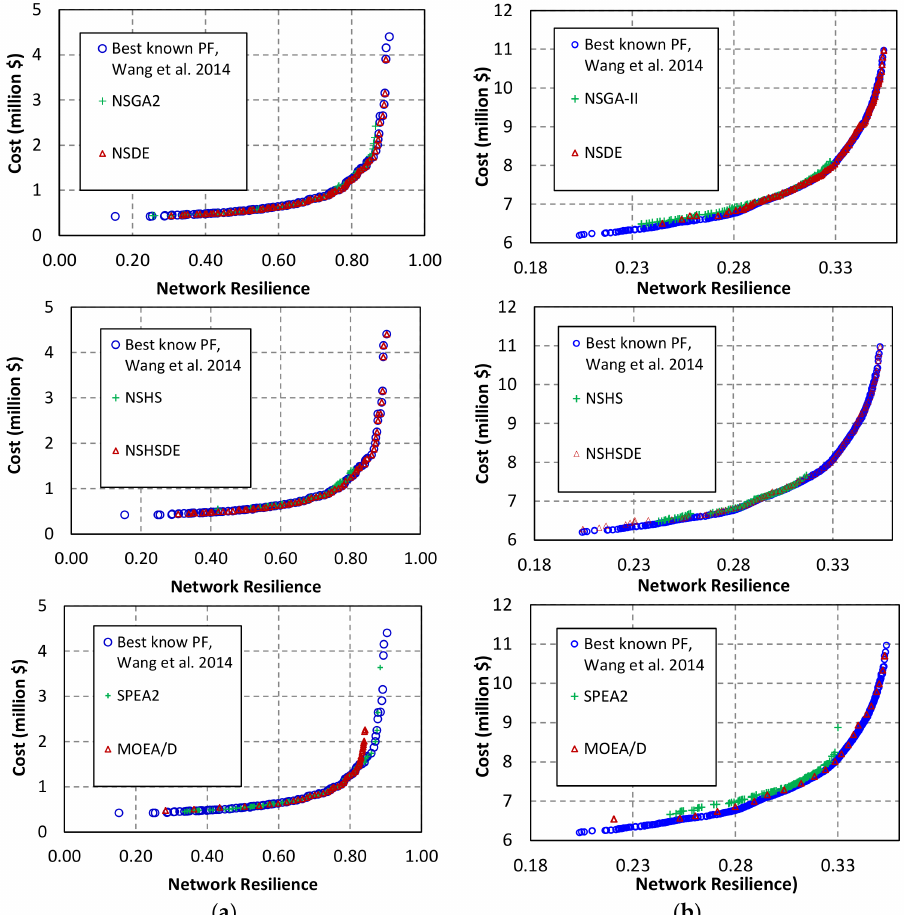
Figure 5. Pareto front (PF) of benchmark problems, ( a ) Two-loop network (TLN) problem; ( b ) Hanoi network (HAN)